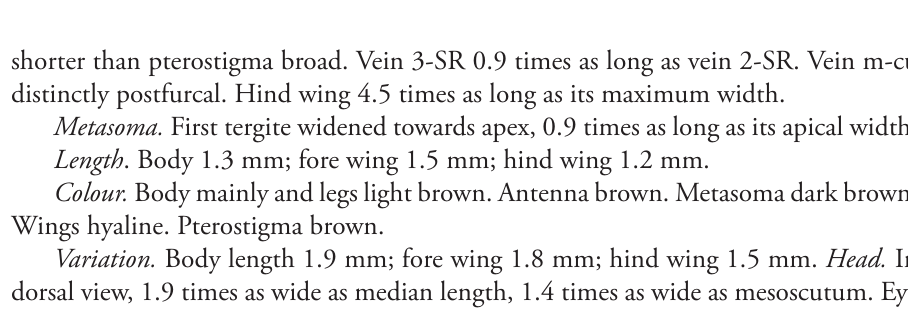
Figure 9. Hoplocrotaphus pospelovi Telenga, 1950 (male, specimen from Turkmenistan) A Head and mesosoma, lateral view B Propodeum, dorsal view C First metasomal tergite D Leg, lateral view E Fore and hind